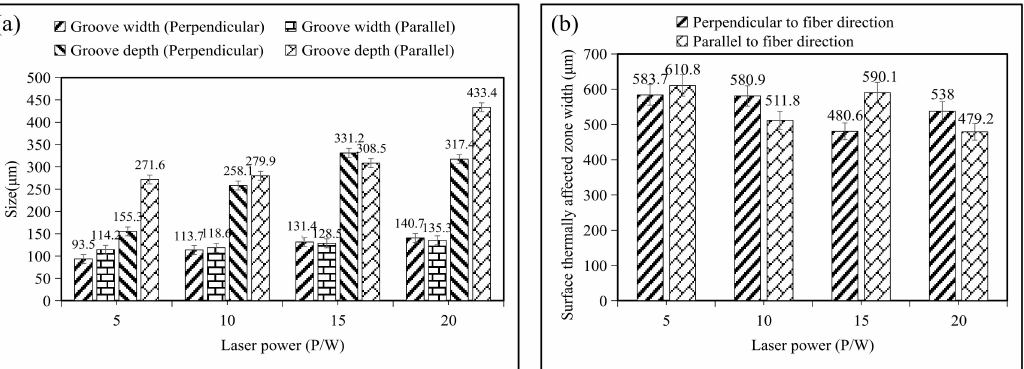
Figure 7. Effect of laser power on the groove of the composite surface (( a ). variation in groove width and depth; ( b ). variation in thermally affected zone